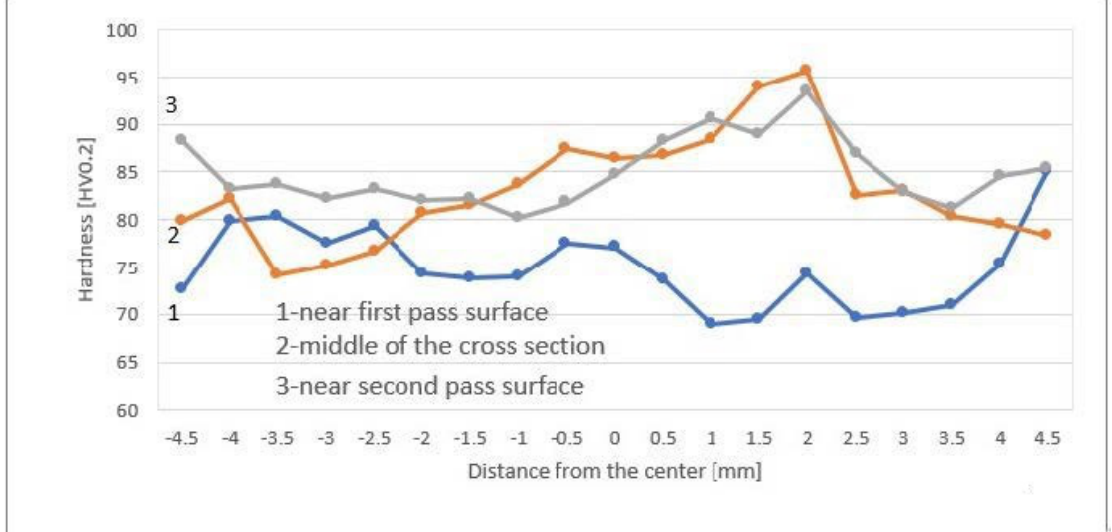
Figure 3. Microhardness profiles across the stir